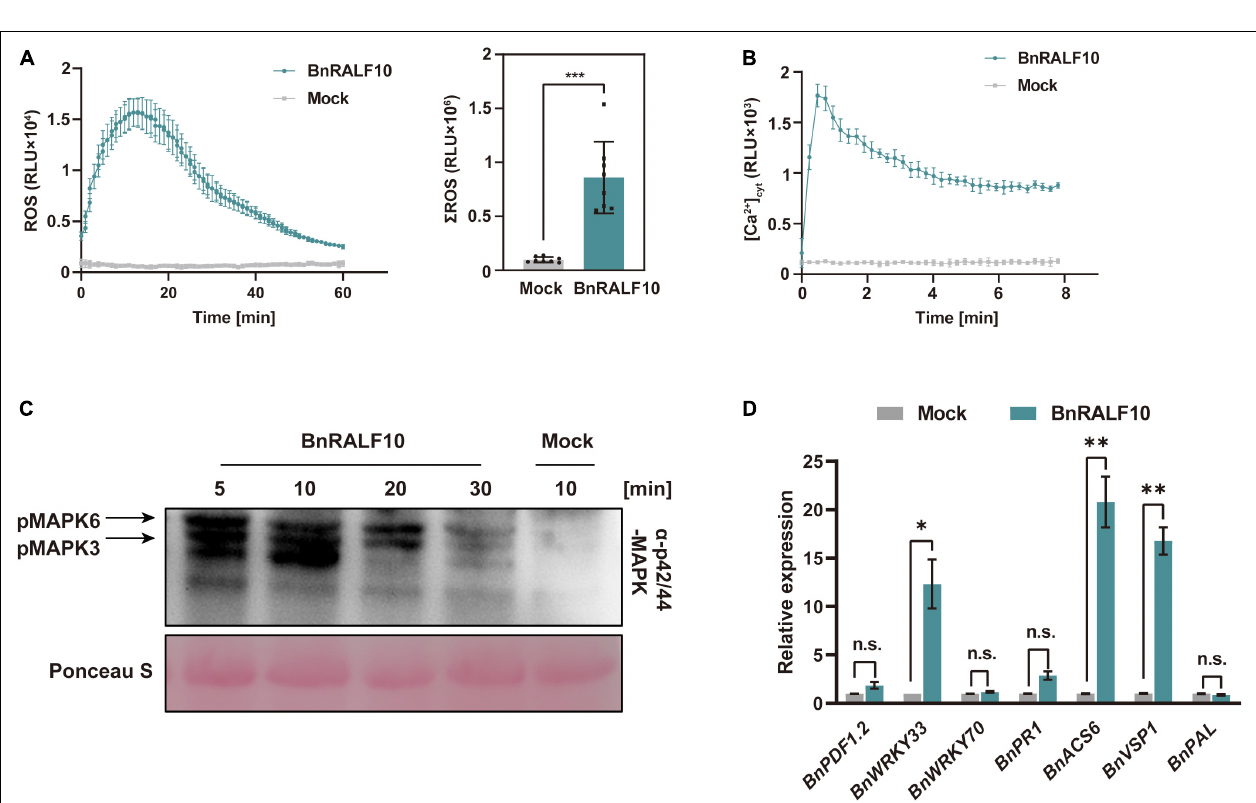
FIGURE 6 | BnRALF10 elicited various immune responses. (A) Reactive oxygen species (ROS) measured in oilseed rape leaf disk assay after addition with 1 µ M BnRALF10 peptide or water (Mock). Shown are the dynamics of ROS production (left) and their total amount (right) as mean values of total photon counts over 60 min. Data are shown as the mean ± SE ( n = 6–8, ∗∗∗ P ≤ 0.001, Student’s t -test). RLU, relative light units. All experiments were repeated three times with similar results. (B) Dynamics in [Ca 2 + ] cyt stimulated by 1 µ M BnRALF10 peptide in Arabidopsis. The 5-day-old seedlings expressing Aequorin gene were treated with solutions containing 1 µ M BnRALF10 peptide or mock. Signals were recorded for 8 min after treatment. Data are shown as the mean ± SE ( n = 8). (C) MAPK activation induced by BnRALF10. Seven-day-old seedlings were exposed to 1 µ M BnRALF10 peptide for 5, 10, 20 or 30 min. Western blot analysis was performed with the phospho-p44/42 MAPK antibody. Ponceau S was used as loading control. (D) Transcription of defense responsive genes in B. napus leaves treated with 1 µ M BnRALF10 for 1 h. Data are shown as the mean ± SE ( n = 3, ∗ P ≤ 0.05, ∗∗ P ≤ 0.01, Student’s t -test). n.s., not significant.